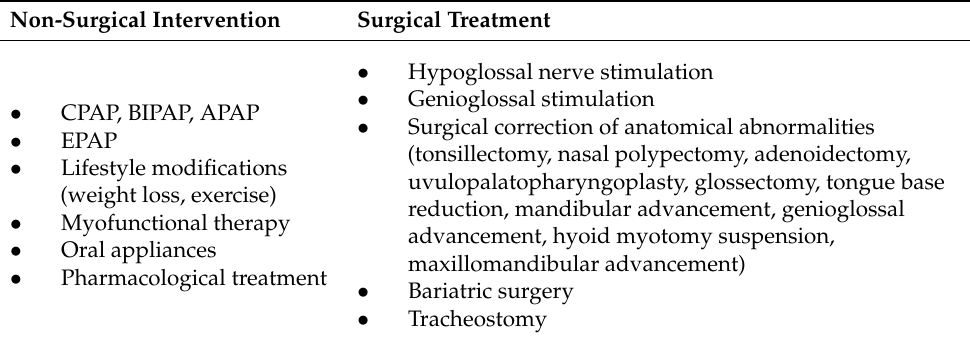
Table 1. Surgical and Non-surgical Intervention of